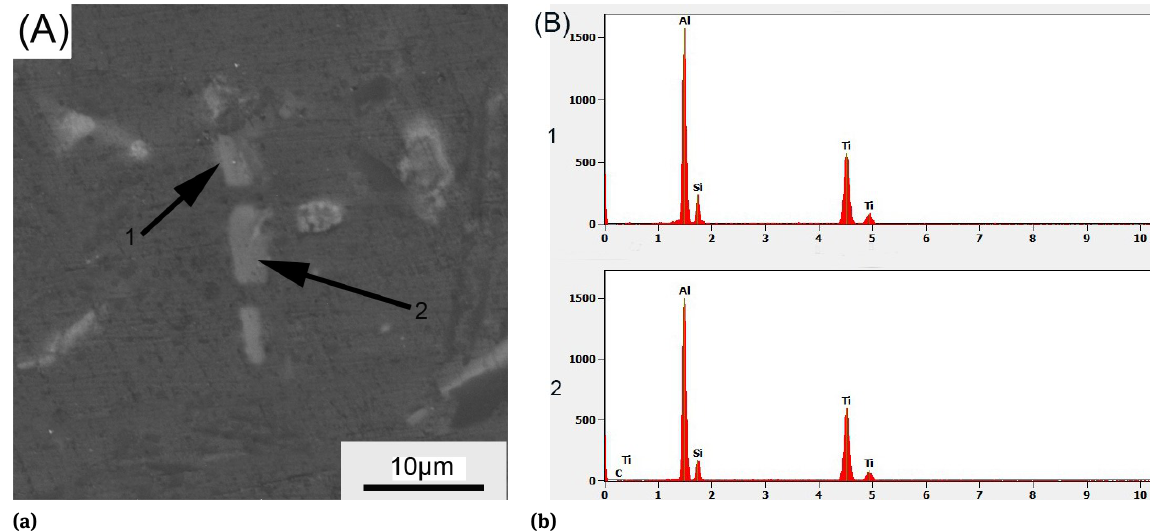
Figure 4: (a) SEM image and (b) energy dispersive spectrum (EDS) analysis of Al 3 Ti/ADC12